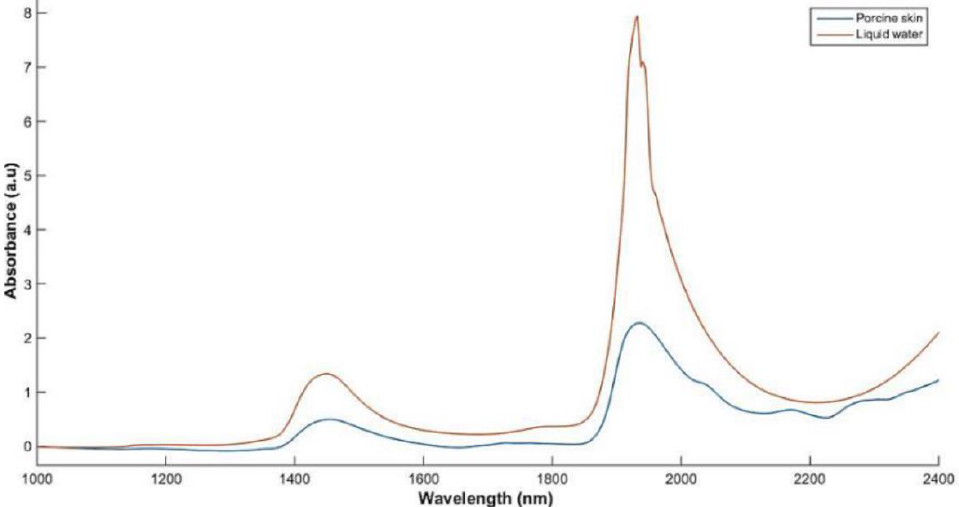
Figure 12. Absorbance spectrum of water and porcine skin in the NIR range. The absorbance peaks around 1400 nm and 1900 nm match almost perfectly, indicating that the absorbance response in the skin is due to the water concentration. Image reproduced with permissions from [13].